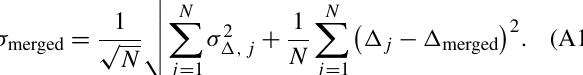
Equation (A1) can be also interpreted as follows. The ex- pression under the square root represents the estimate of the standard deviation for small samples (SPARC, 2013), which, being divided by the square root of the number of measure- √ N , gives the standard error of the ments